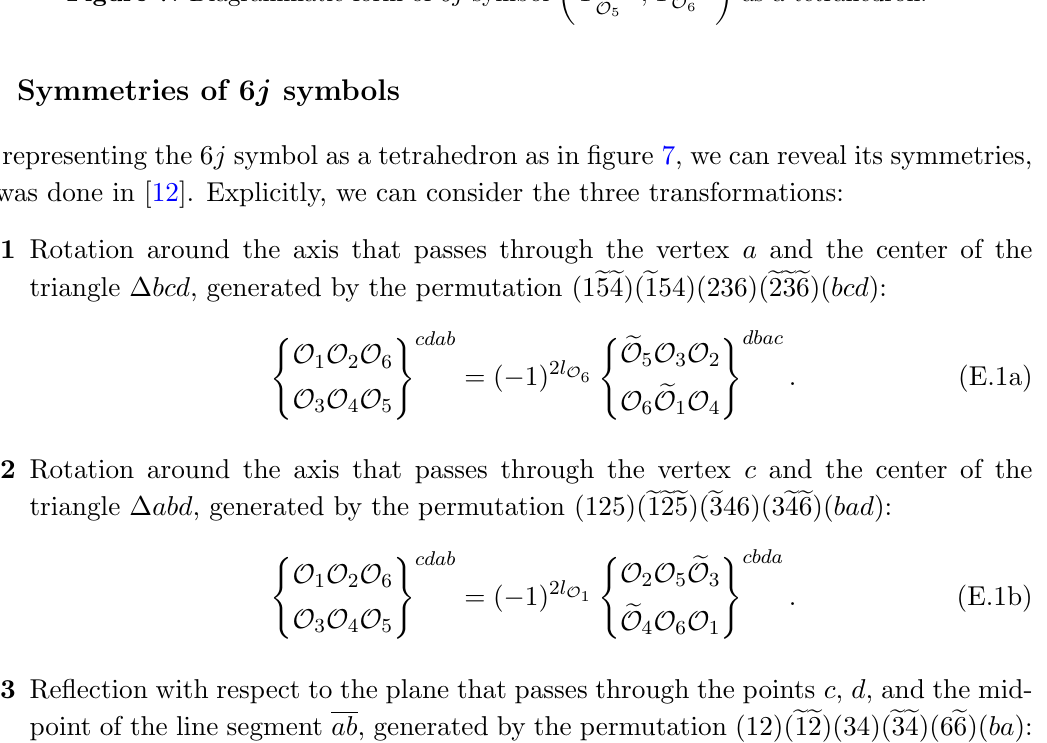
Figure 7 . Diagrammatic form of 6 j